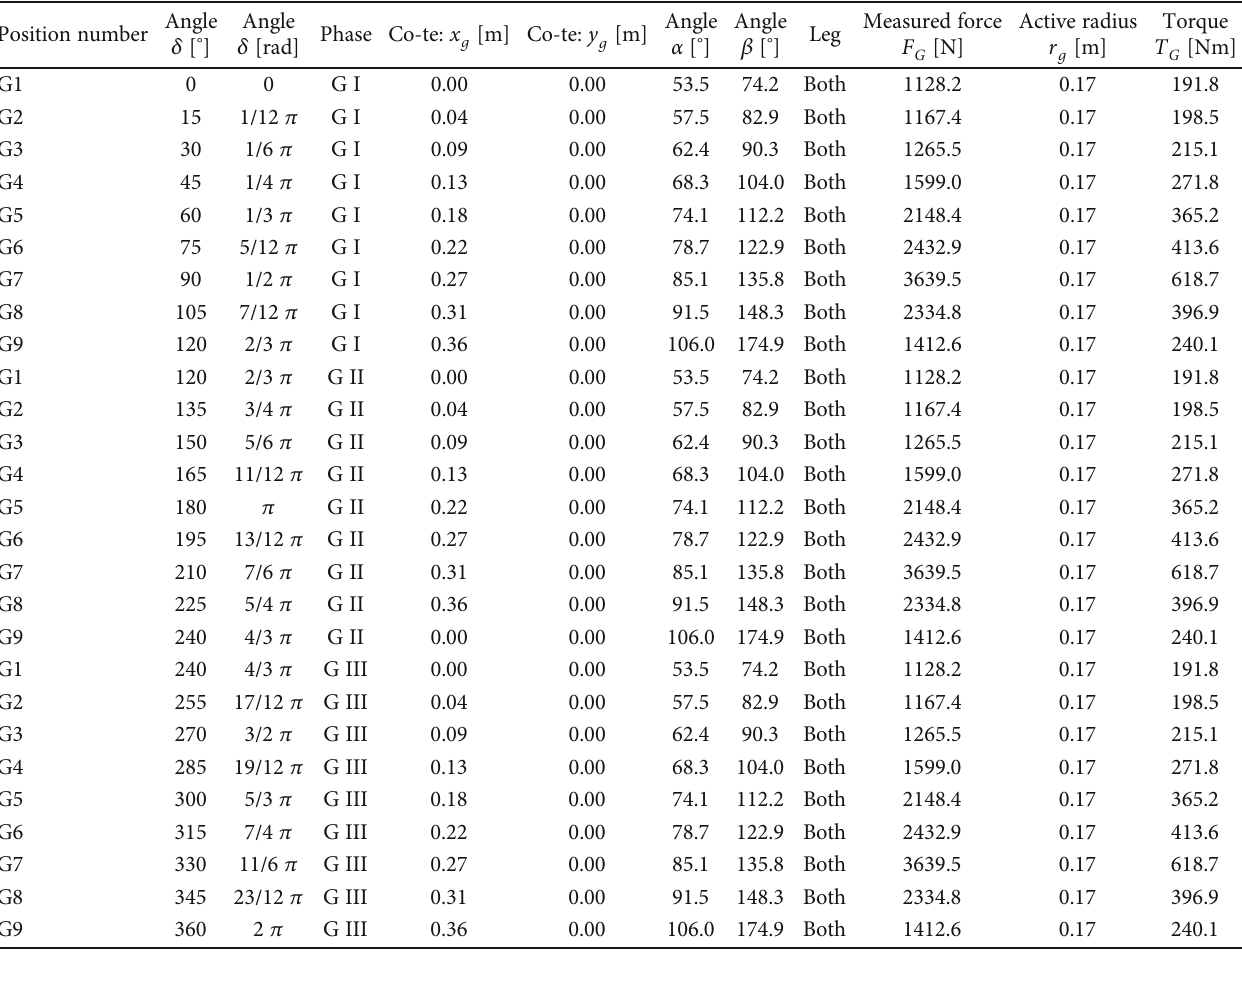
Table 2: Data from analysis and tests for the gantry.